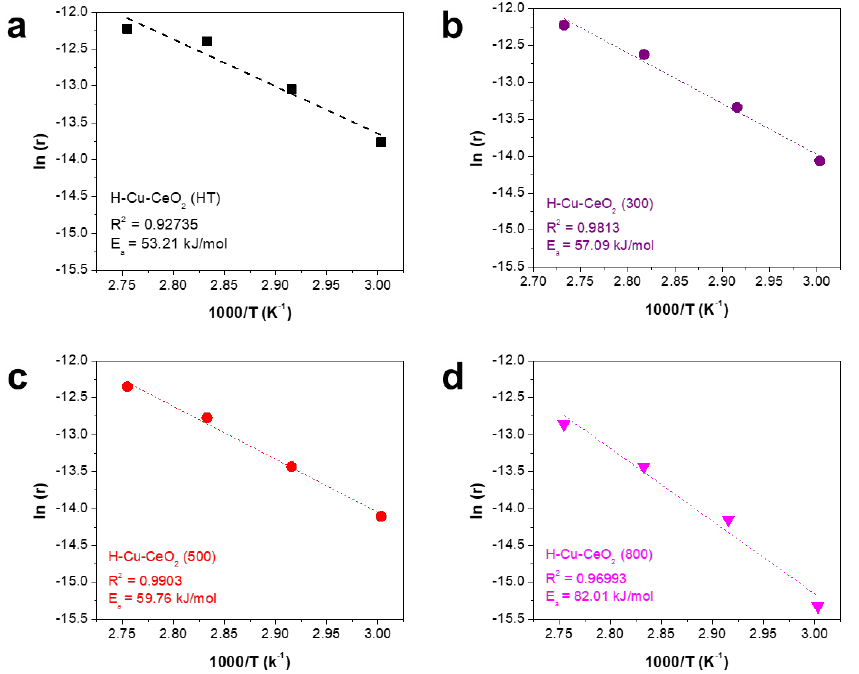
Figure 7. Arrhenius plot for CO oxidation, employing the H-Cu-CeO 2 catalysts: ( a ) H-CeO 2 (HT), ( b ) H-CeO 2 (300), ( c ) H-CeO 2 (500) and ( d ) H-CeO 2 (800).